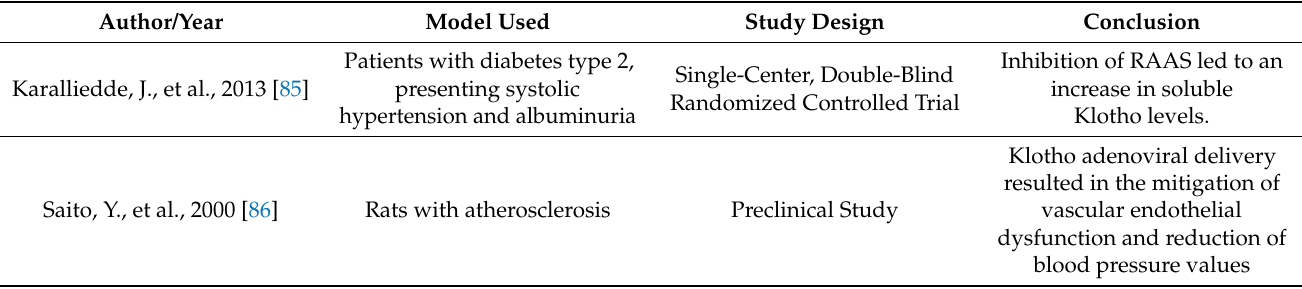
Figure 2. Klotho/FGF and PTH axis in CKD. In kidneys, parathyroid hormone (PTH) leads to an increase in calcium (Ca 2 +) absorption and Vitamin D synthesis, whereas it diminishes phosphorus absorption. On the other hand, PTH stimulates both phosphorus and calcium efflux in bones. In turn, PTH-stimulated Vitamin D production increases the gastrointestinal reabsorption of these minerals. As a result, both gastrointestinal calcium reabsorption and its efflux from bones contribute to a rise in calcium excretion. Phosphorus (PO 42 − ) is also eliminated as a consequence. In chronic kidney disease (CKD) (red dotted line), there is a reduction in Klotho expression, alongside a decrease in Vitamin D levels and an increase in fibroblast growth factor (FGF-)23 levels. It is important to mention that the decrease of Vitamin D is related to the decrease of Klotho in the kidneys, which then leads to a rise in FGF-23 levels in the bones. As a consequence, this hormone diminishes Vitamin D production. As a result of this axis dysregulation, the inhibition of PTH synthesis promoted by these components is lost, which leads to a rise in the levels of this hormone, which also contributes to the elevation of these molecules. Secondary hyperparathyroidism associated with CKD might be a result of the described imbalance in this axis for CKD patients. Table 1. Klotho and the Klotho/FGF-23 axis in CKD-associated cardiovascular disease. Summary of some of the studies analyzed in this review, concerning the role of Klotho and the Klotho/FGF- 23 axis in cardiovascular disease, an important and common morbidity and cause of mortality in CKD